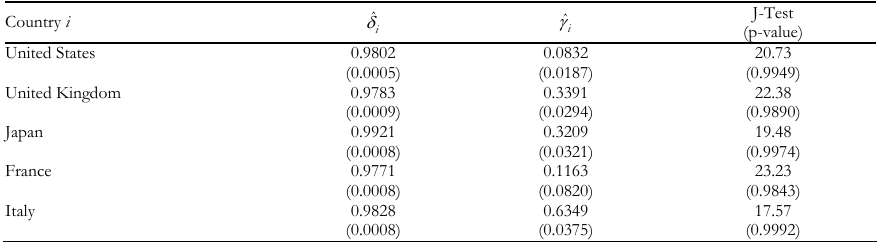
Coefficient estimates and J-tests for the CCAPM asset pricing models of the analyzed countries Country i